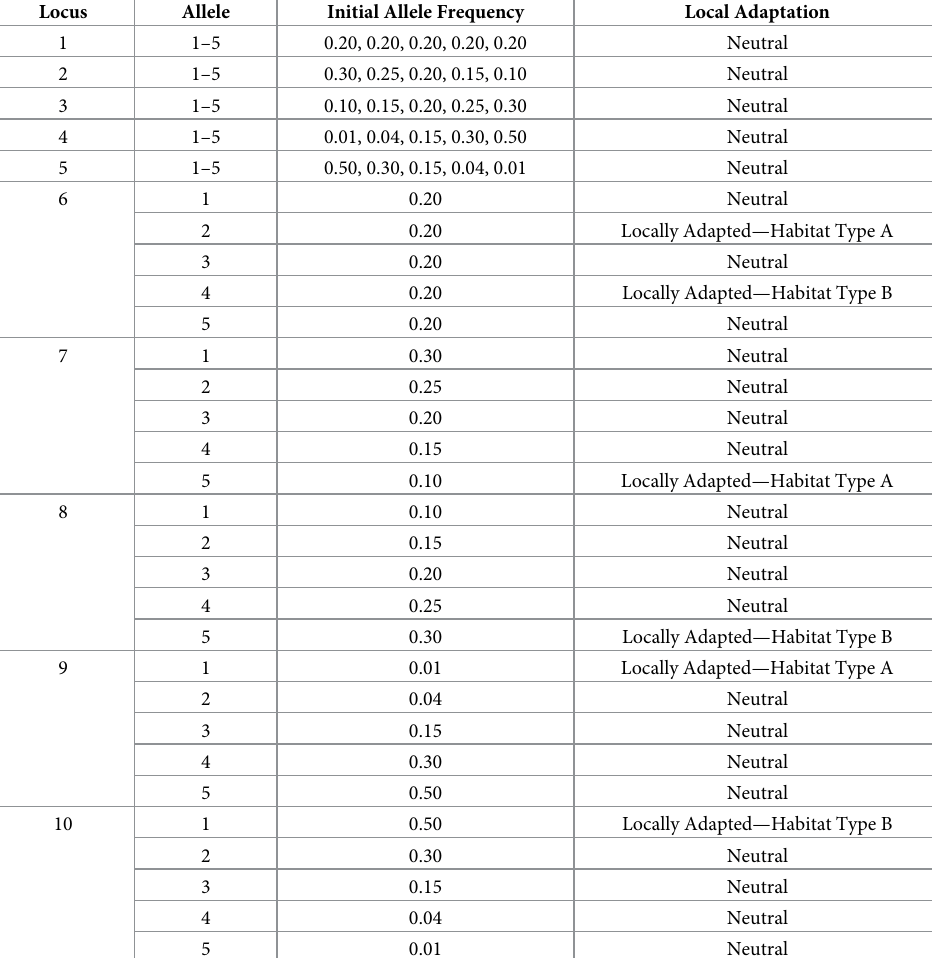
Table 2. Initial allele frequencies for 10-locus